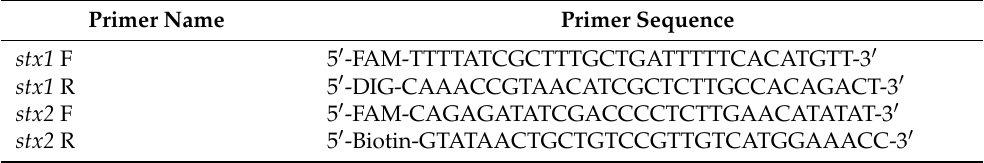
Table 1. Primer sequences used in this